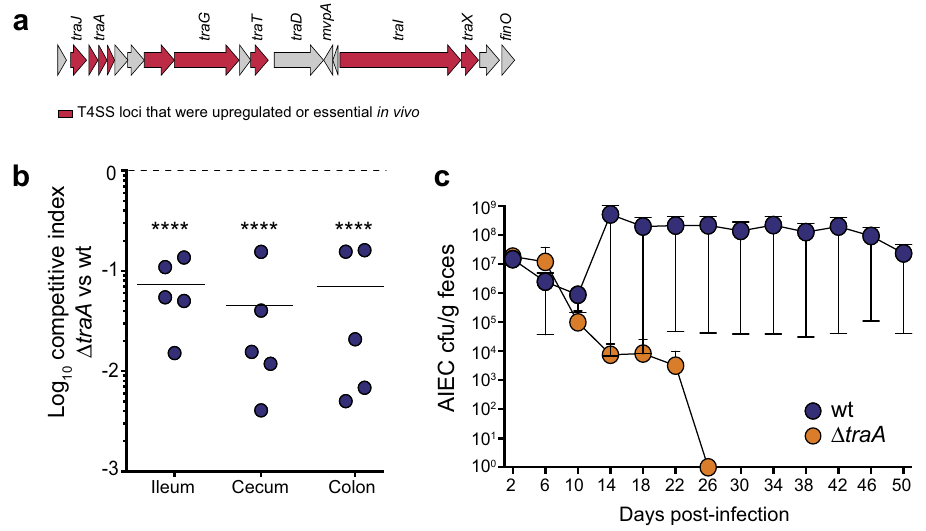
Fig. 3 T4SS is required for AIEC persistence in the gut. a Graphical representation of T4SS cluster in AIEC str. NRG857c. b Wild-type AIEC outcompeted the Δ traA mutant in all gut tissues. Individual AIEC populations were enumerated in different tissues 12 days post-infection. Each data point represents the competitive index from an individual animal. Data presented are means ± SEM; n = 5 biologically independent replicates. Groups were compared against a value of “ 0 ” using Holm – Sidak method for multiple t -tests (two-tailed), **** P < 0.0001. c Fecal burden of different AIEC strains was monitored for 50 days. Results represented as colony forming units (cfu) per gram (g) feces. Data are means ± SEM; n = 5 biologically independent replicates. Groups were compared using two-tailed Mann – Whitney U test, P =